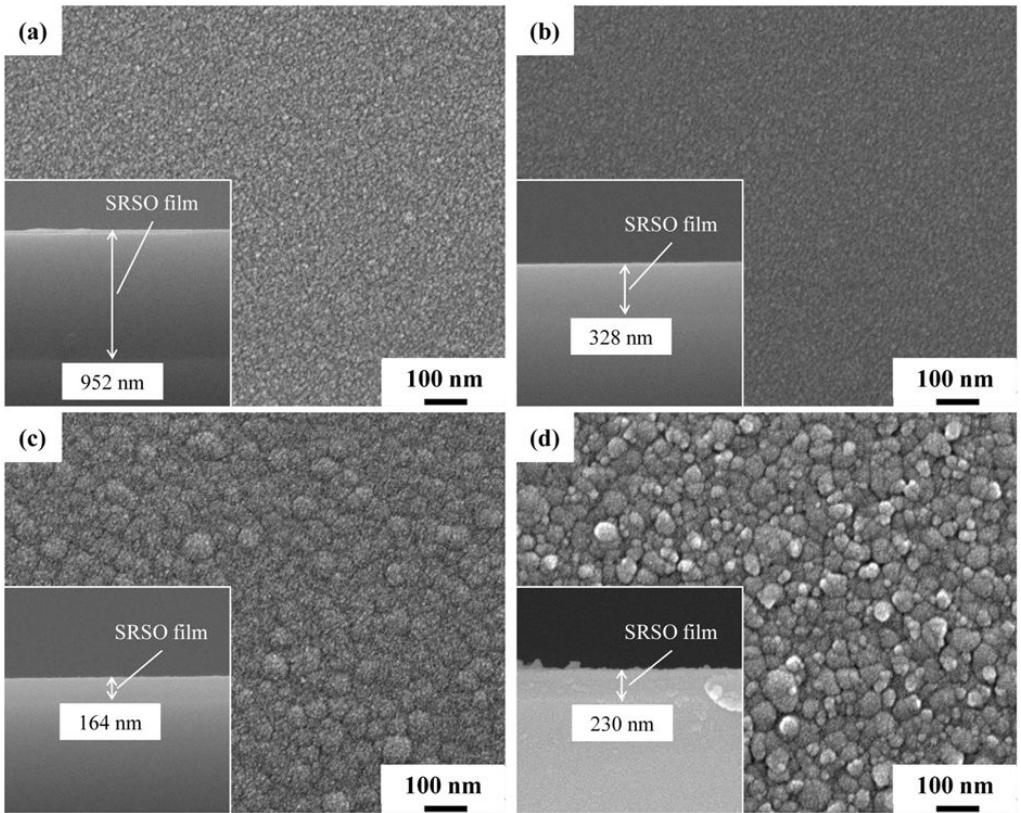
/Ar flow ratios of (a) 1:7, (b) 1:3, (c)1:1, and (d) 3:1 with a 2